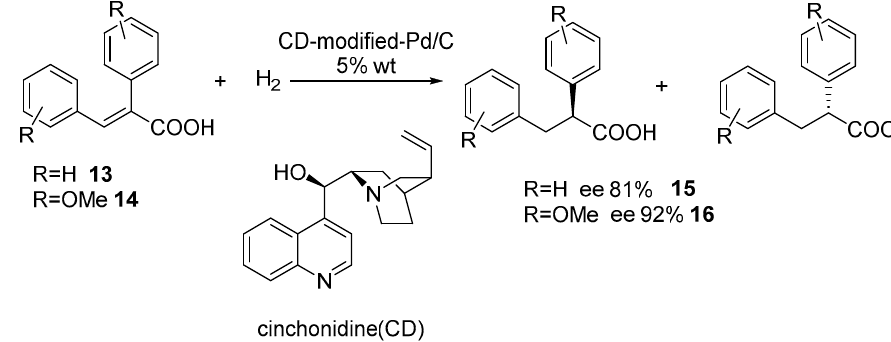
published [28–31]. The asymmetrical hydrogenation of prochiral compounds using modified Pd/C cat-